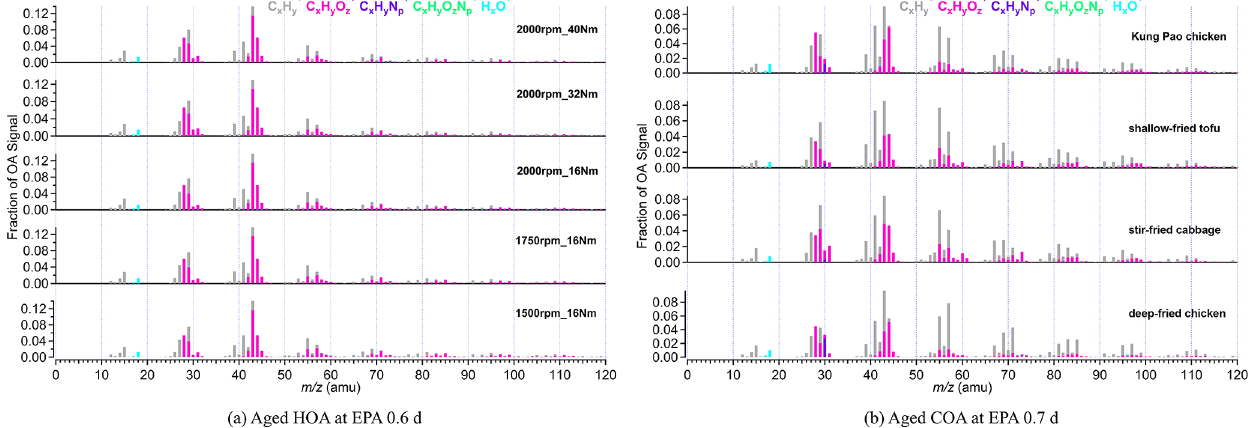
Figure 1. (a) The mass spectra of aged HOA emission from different vehicle running conditions at EPA 0.6d. (b) The mass spectra of aged COA from four Chinese dishes at EPA 0.7d. In total, five running conditions cover different speeds and torques, including 1500rpm_16Nm, 1750rpm_16Nm, 2000rpm_16Nm, 2000rpm_32Nm, and 2000rpm_40Nm. The four dishes include deep-fried chicken, shallow-fried tofu, stir-fried cabbage, and Kung Pao chicken. Table 1. The θ angles among the mass spectra of (a) aged HOA at EPA 0.6d and (b) aged COA at EPA 0.7d. (a) θ